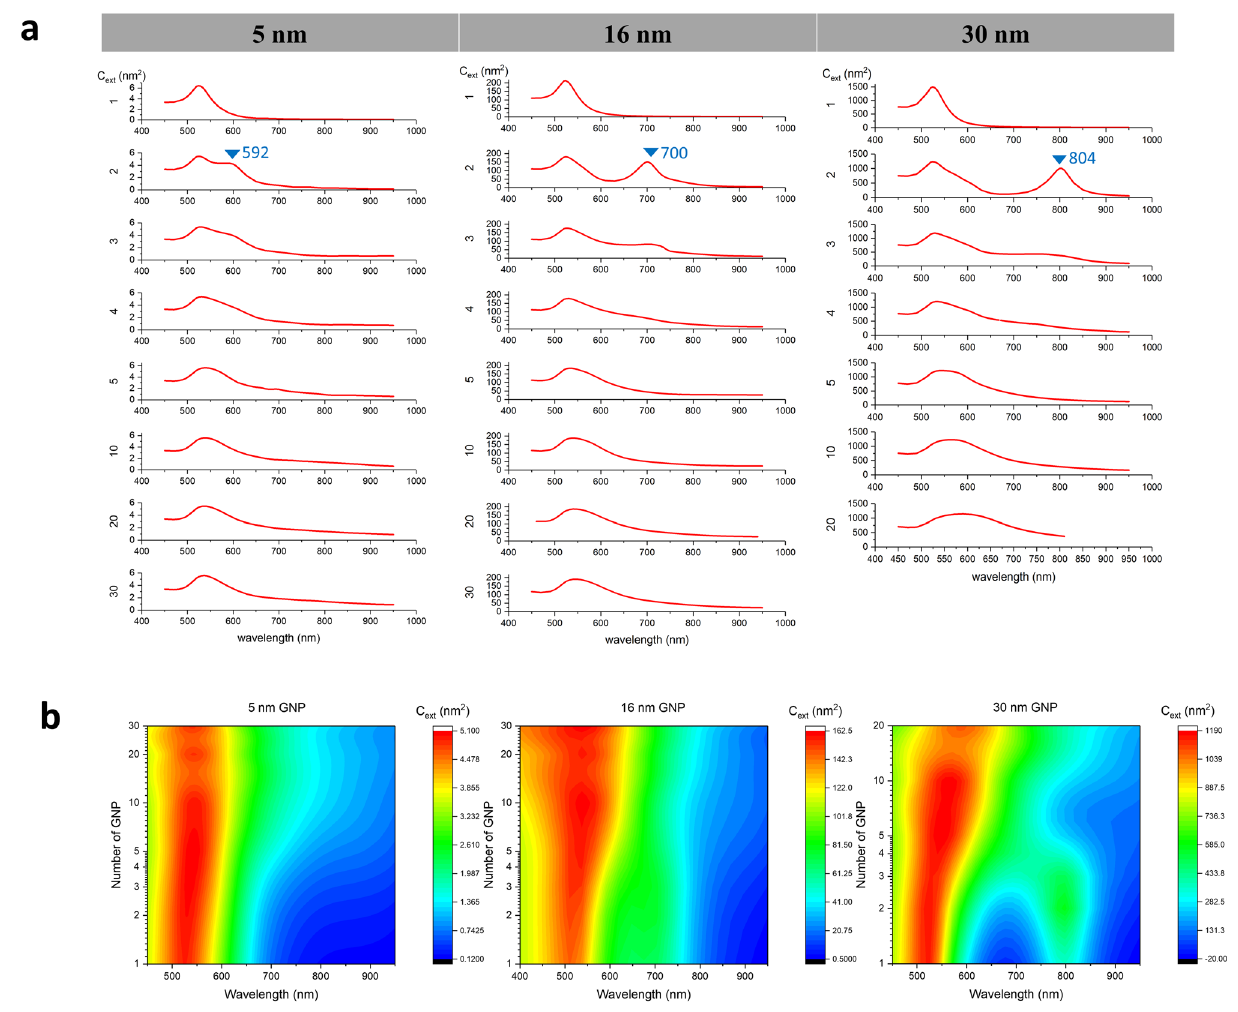
Figure 1. Averaged extinction cross-section of aggregated 5, 16, and 30 nm GNP by spectra plots ( a ) and contour plots produced with fitting and smoothing algorithms ( b ). ( a ) Number on the left of the y-axis indicate the number of GNPs in the aggregate. A second peak can be observed for 2 particle aggregations at various wavelength and gradually diminished with increase of aggregation sizes up to 30 (5 and 16 nm GNP) and up to 20 (30 nm